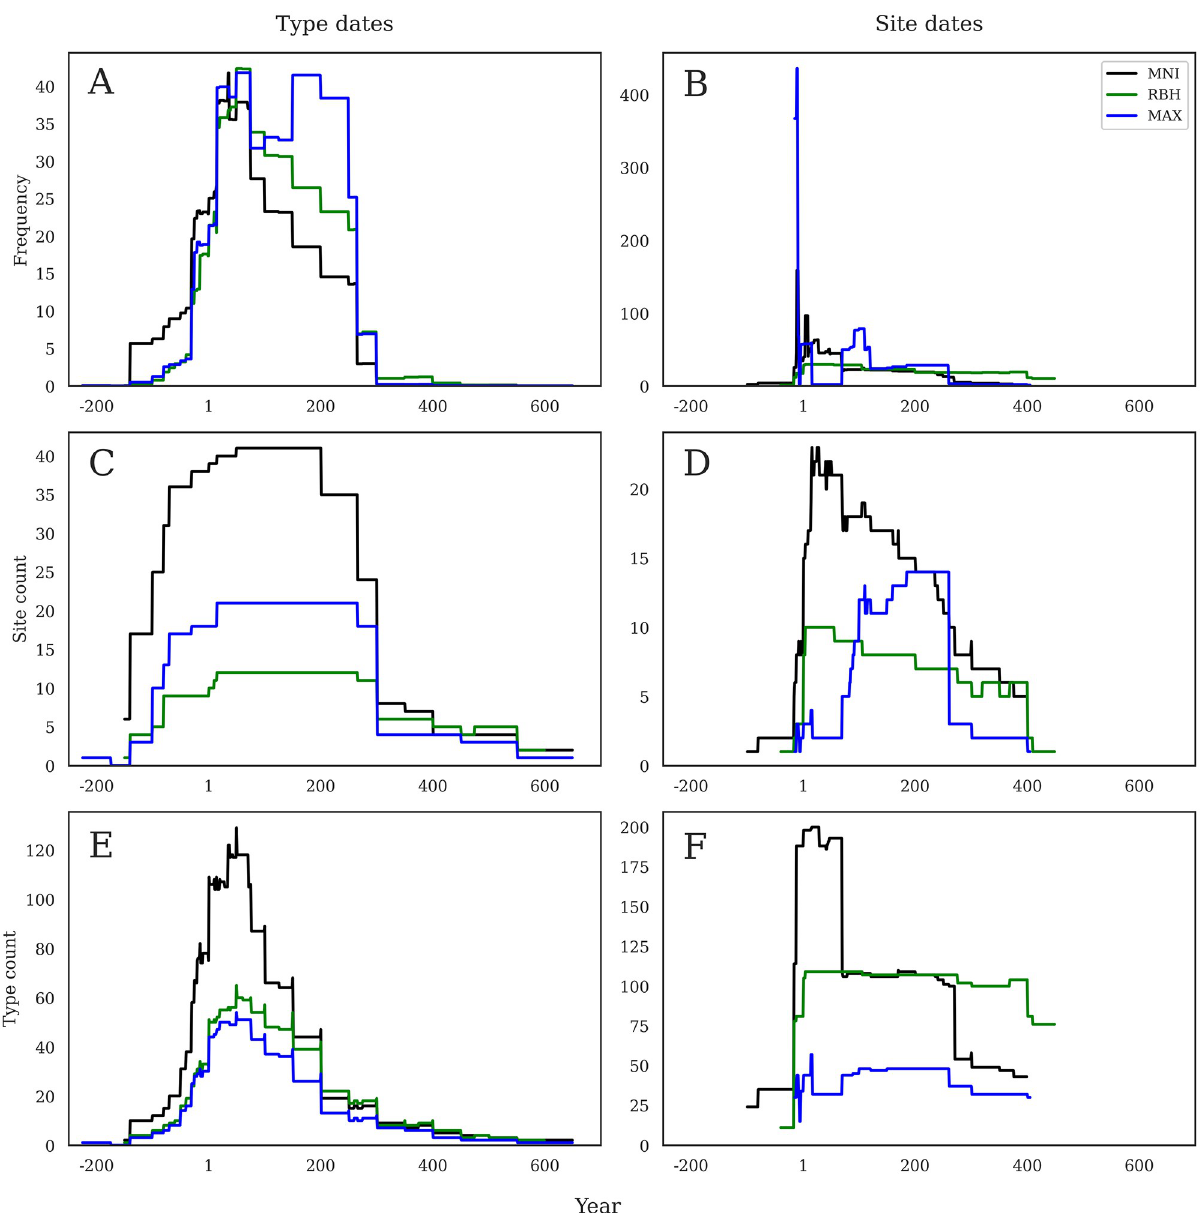
Fig 4. a-f. Comparison of quantification methods. Graphs show comparison across the three different methods of analysis according to production dates (left) and consumption dates (right). Note that Y axes are not constant.